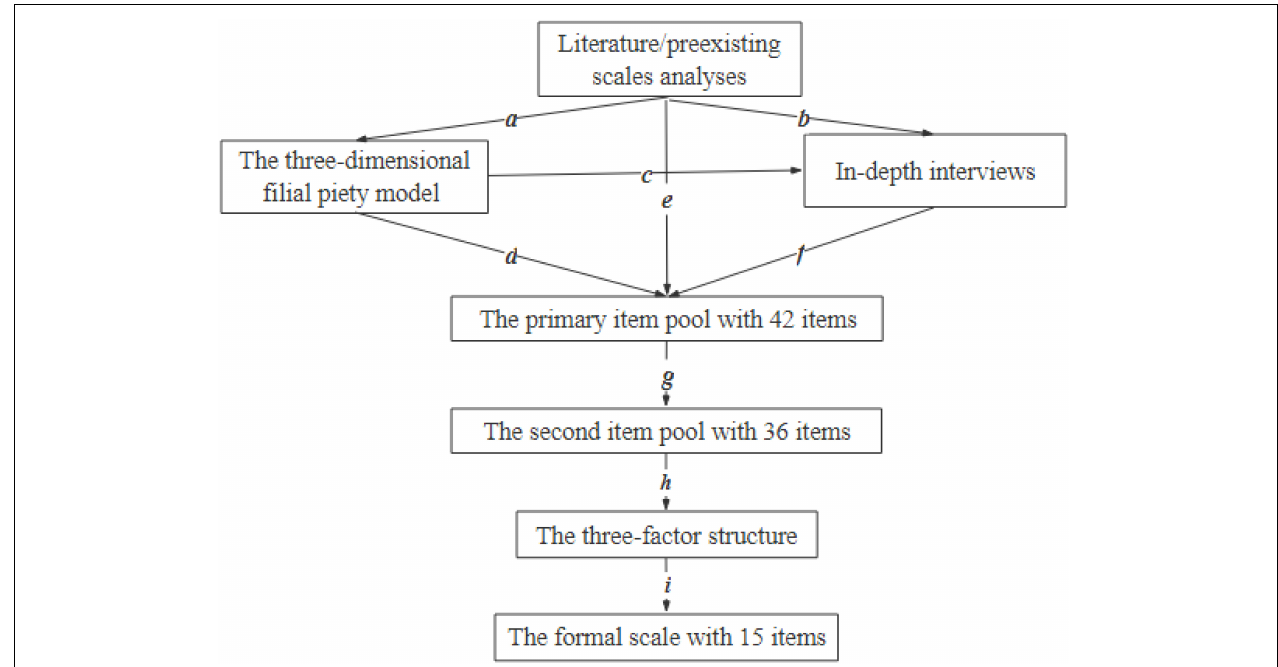
FIGURE 2 | Process of generating initial 15 items of TDFPS. In this figure, “a” proposed the three-dimensional filial piety model based on literature and preexisting scales analyses; “b and c” formed in-depth interviews outlines based on literature and preexisting scale analyses and the three-dimensional filial piety model, respectively; “d, e, and f” generated items based on the model, the analyses of literature and preexisting scales and the in-depth interviews, respectively; “g” assessed these items by experts and the target group with low education; “h” conducted the EFA; “i” conducted the CFA to verify the three-factor